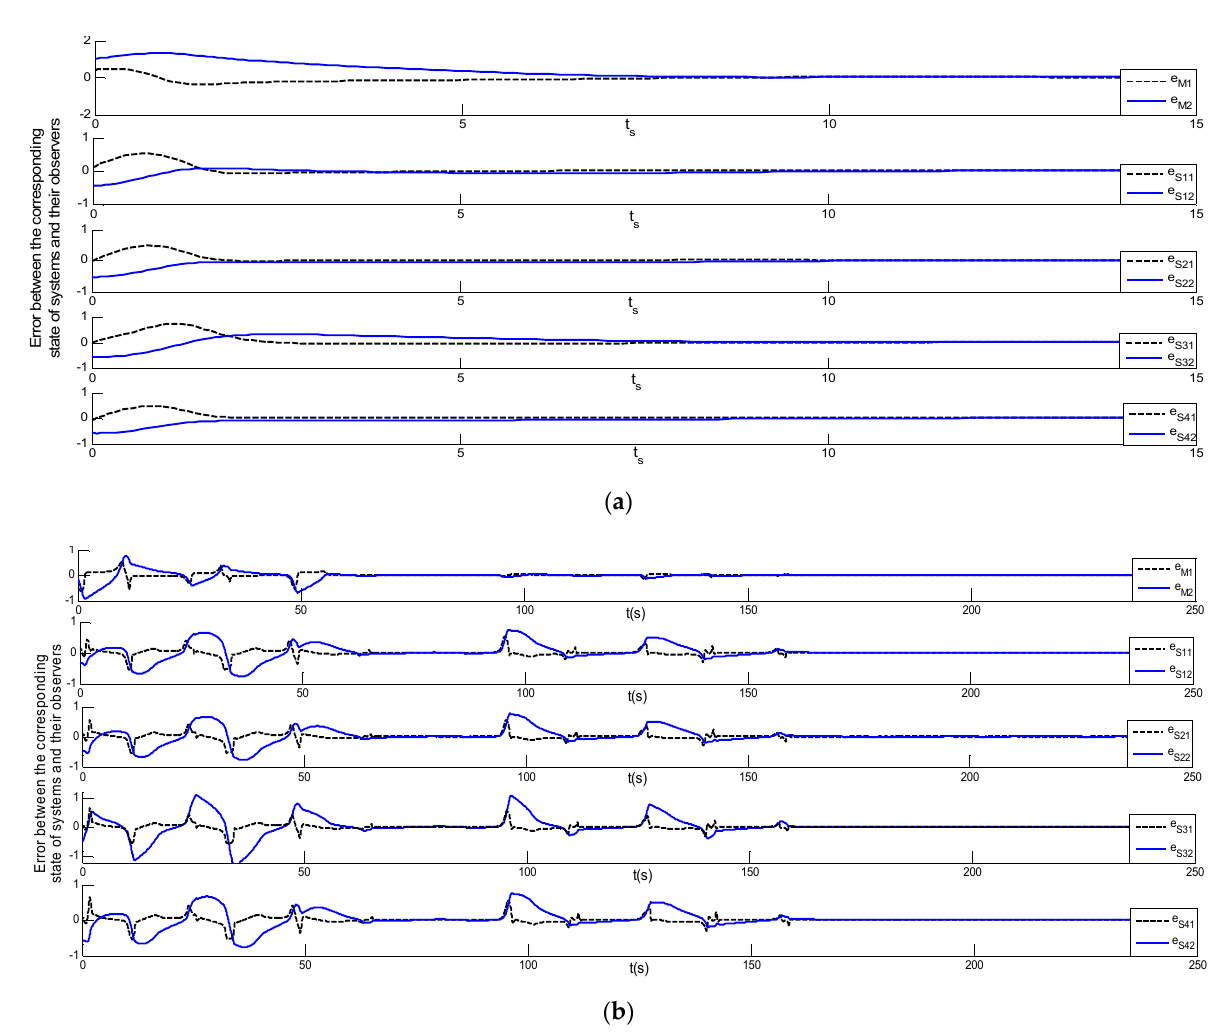
Figure 5. Errors between the corresponding states of master and observer: ( a ) (X M -X MO ) and slave; ( b ) corresponding observer (X SI -X SIO ) of Theorems 1 and 2.